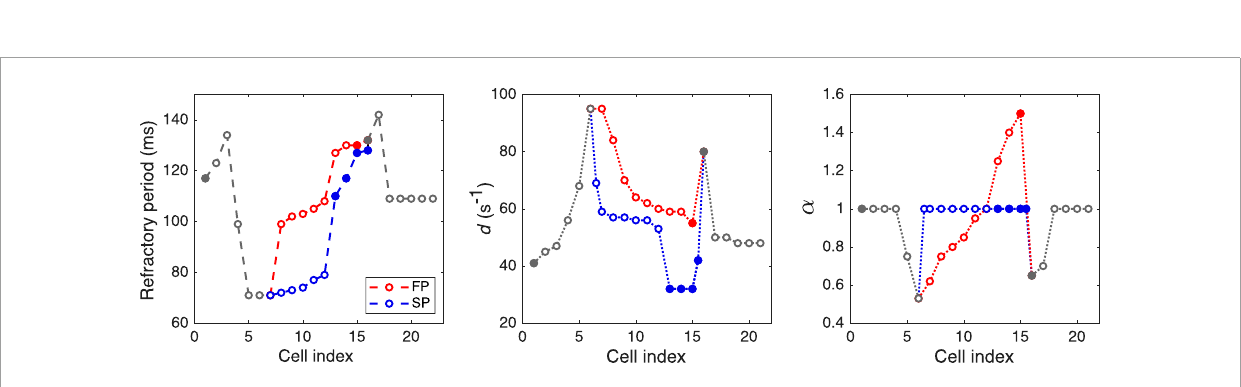
FIGURE 3 Distributions of refractory period for uncoupled model cells, coupling coefficient d , and coefficient of coupling asymmetry α . Opaque and filled circles denote excitable and pacemaking cells, respectively. For d and α plots, the data in SP with indexes 6.5 and 15.5 correspond to “verical” coupling between the rows of the AVN